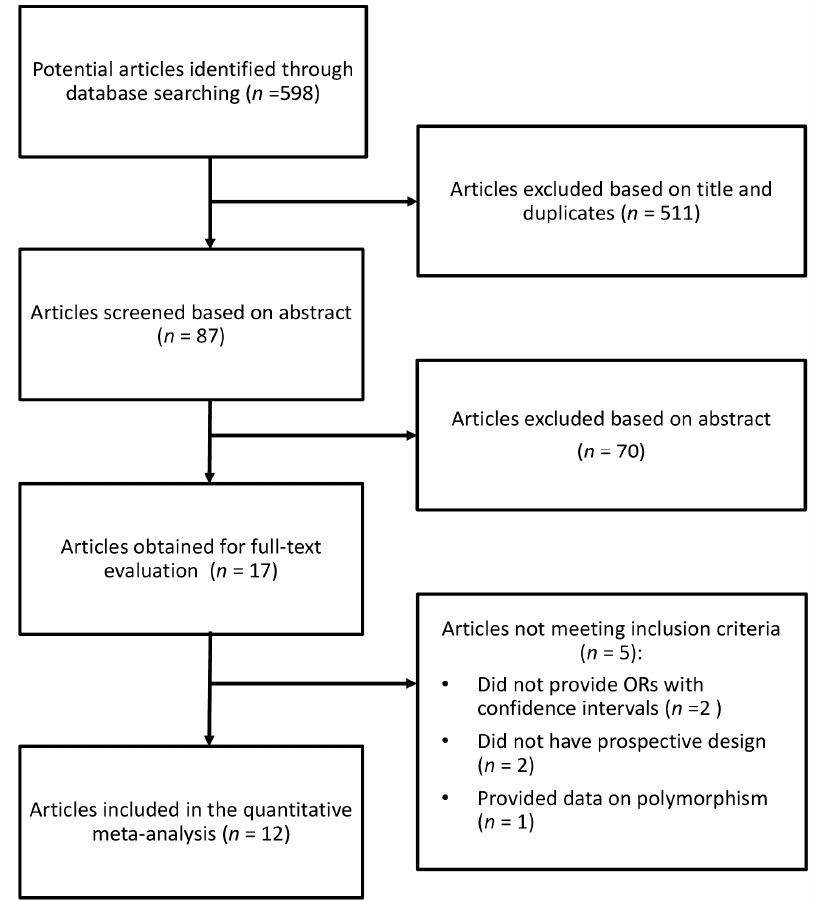
Figure 1. Selection process of relevant studies reporting on the association between coffee consumption and endometrial cancer risk.